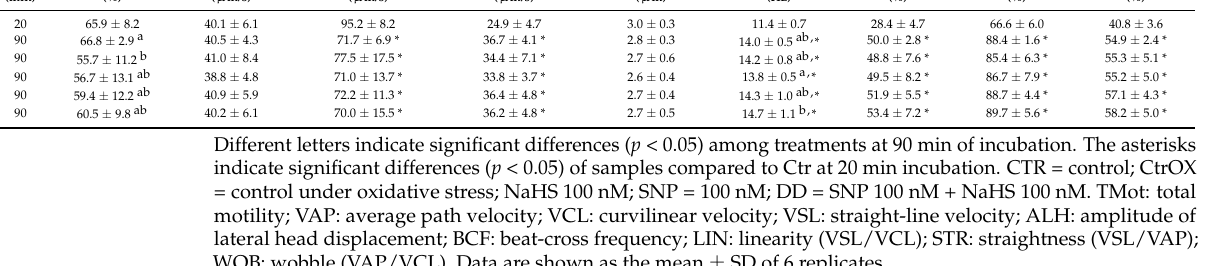
Table 1. The effect of NaHS, SNP, and their combination (DD) on kinetic parameters of boar spermatozoa under oxidative stress. Time Treatment (min)